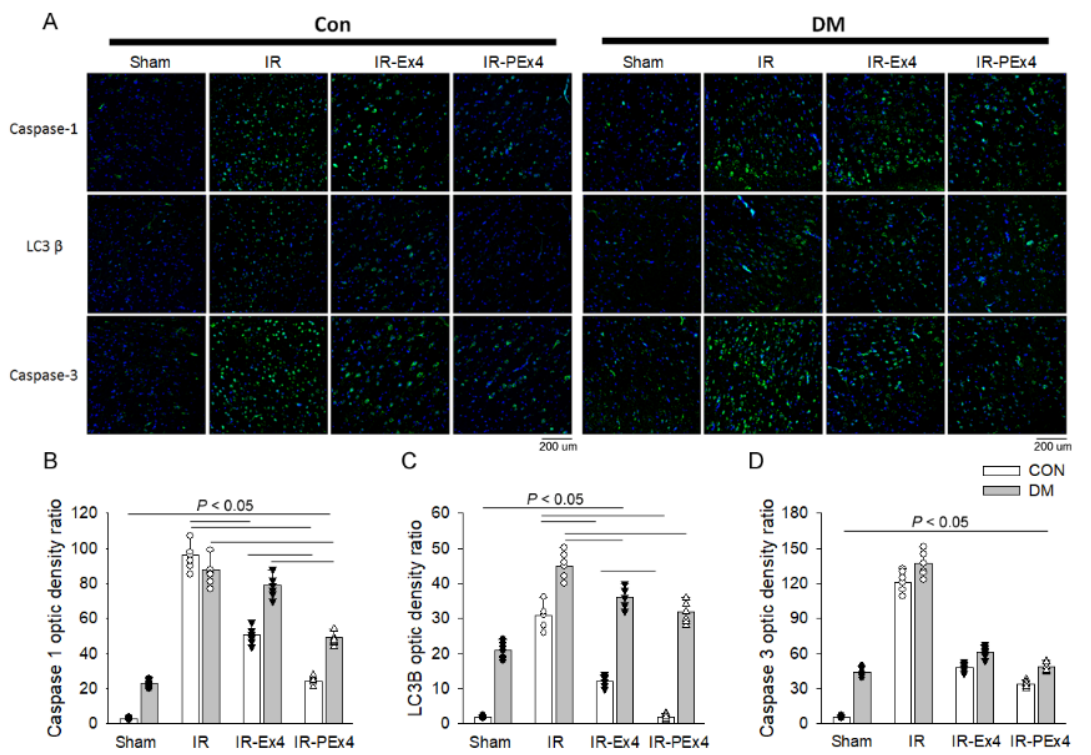
Figure 6. Effect of Ex-4 and PEx-4 treatment on the brain expression of pyroptosis, autophagy and apoptosis in control and DM rats subjected to global brain ischemia injury (IR). ( A ): the level of green fluorescent intensity of Caspase-1-mediated pyroptosis, LC3B-mediated autophagy and Caspase-3-mediated apoptosis is determined with an immunofluorescent stain in the rat brains. DM significantly enhanced brain Caspase-1 ( B ), LC3B ( C ) and Caspase-3 ( D ) stains indicated by green fluorescence, whereas IR further and significantly increased Caspase-1, LC3B and Caspase-3 stains in the Con and DM brains as compared to respective Con and DM brains. Ex-4 (IR-Ex4) and PEx-4 (IR-PEx4) treatment significantly reduced IR-enhanced Caspase-1, LC3B and Caspase-3 flu- orescence in the brains of control and DM rats. Data are expressed as mean ± SEM in each group ( n = 6) using the single values. The statistical difference is indicated by the horizontal line with p < 0.05 between groups using one-way ANOVA, followed by Bonferroni’s post hoc test. Scale bar = 200 µm. Each symbol represents one sample in different groups.